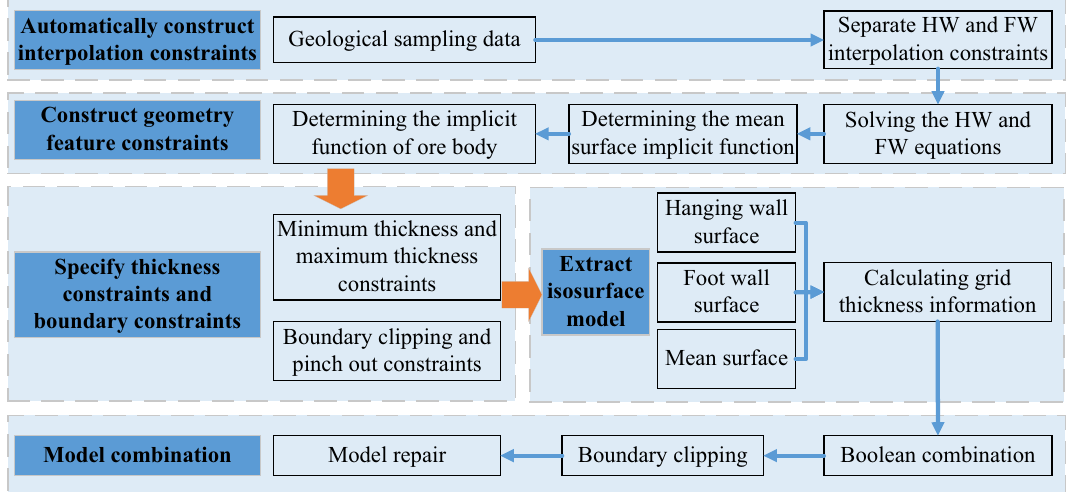
Figure 7. Overall flow chart of the modeling method for narrow vein type ore bodies.